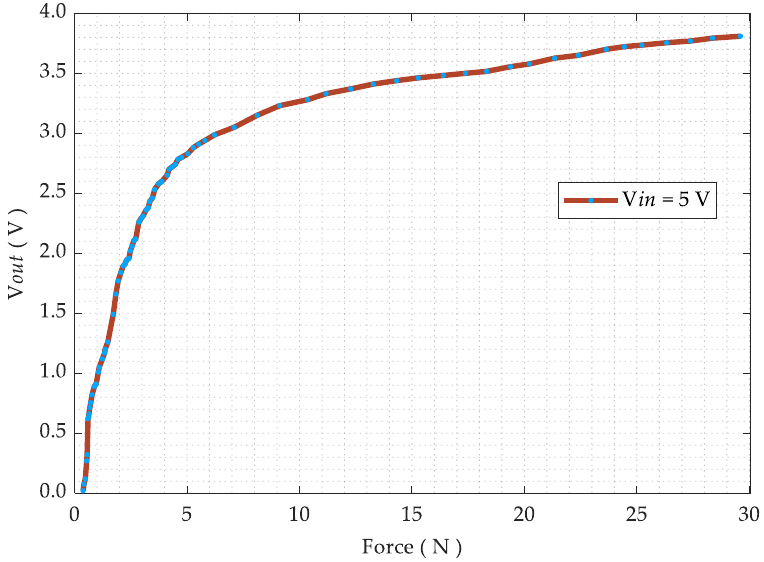
Figure 7. Voltage–pressure graph, when the pressure sensor is connected in a 5.0 V voltage divider configuration using a 10 kΩ 0.1% precision resistor.